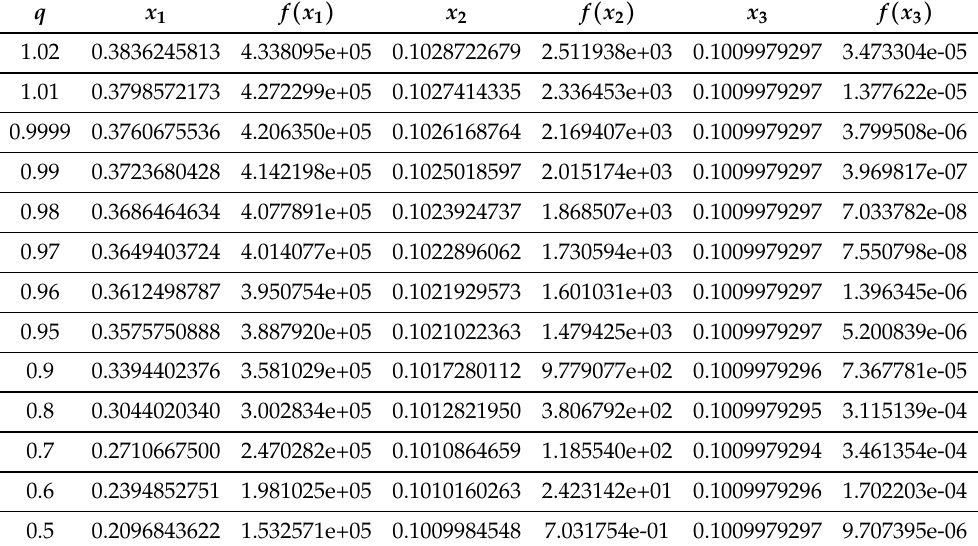
Table 4. The computed values of x i and f ( x i ) for i = 1,2,3 and different values of q by using QAG 2.